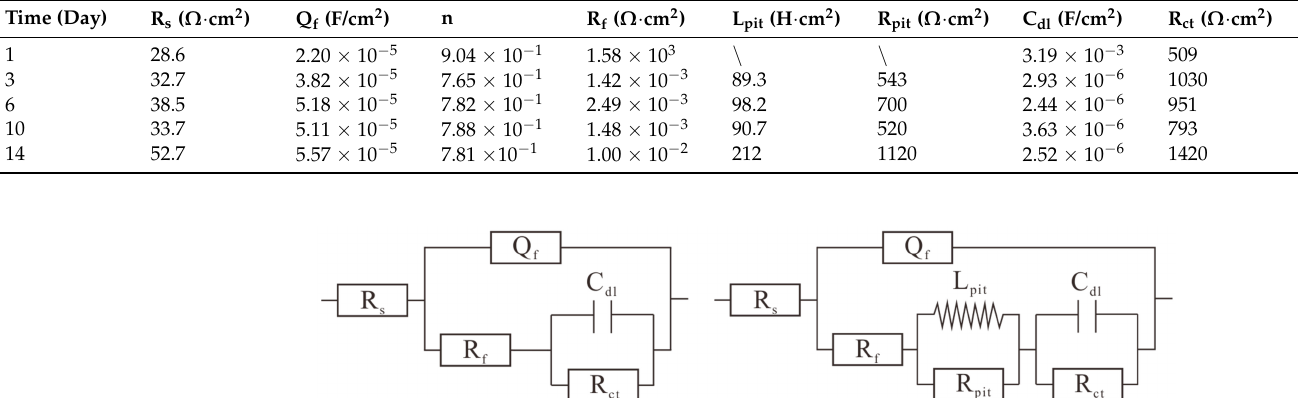
Table 3. Fitted electrochemical parameters for AZ31B magnesium alloy after immersion in abiotic mudflat.